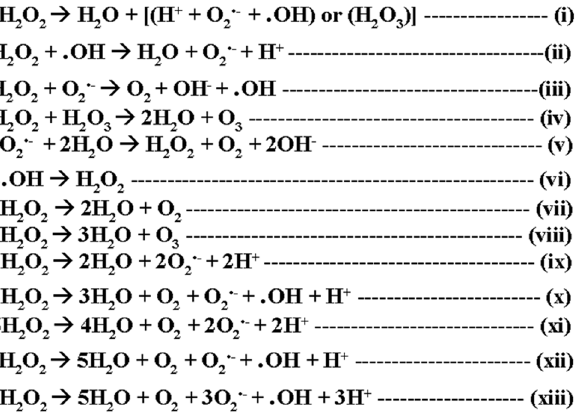
Figure 6. Probable DROS reactions that could be envisaged to occur in